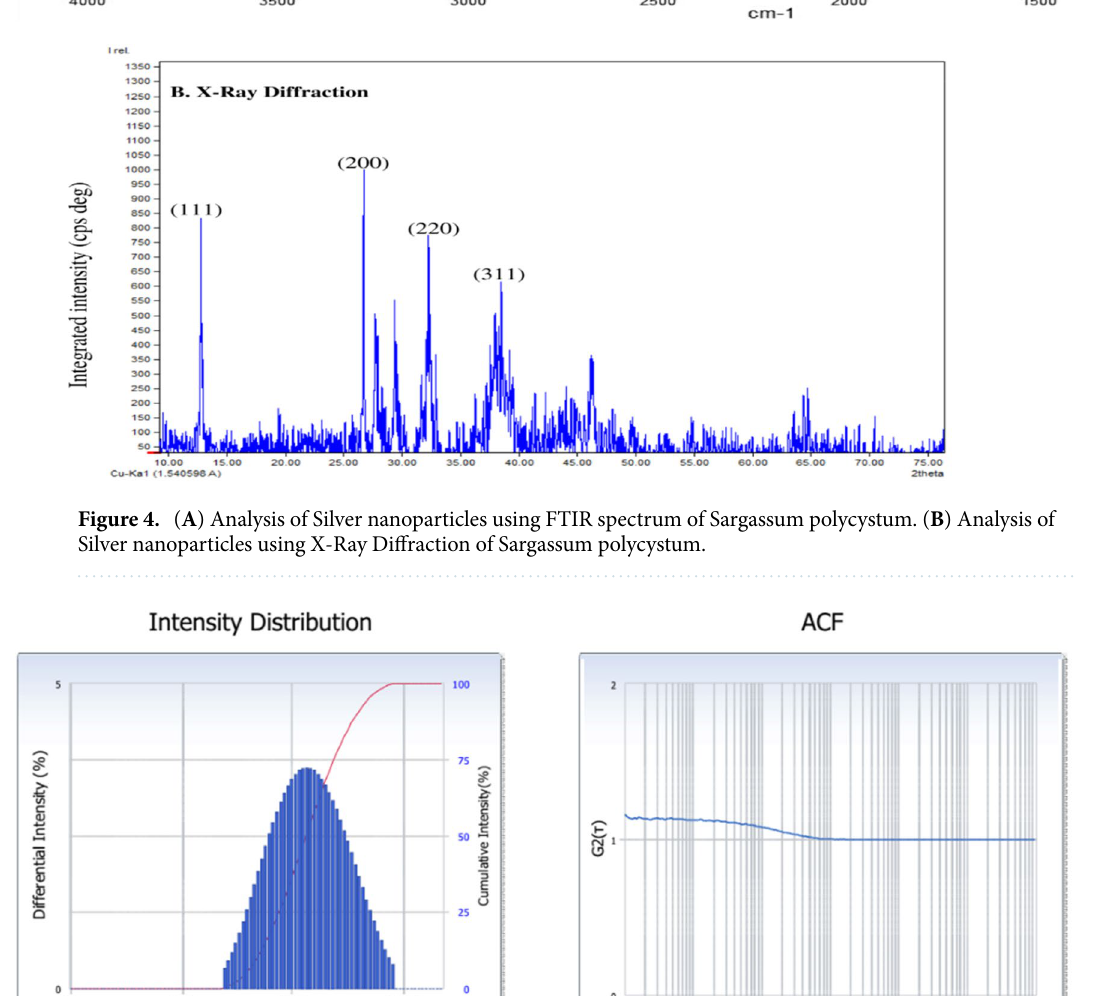
Table 1. Fourier transforms infrared spectroscopy analysis evaluated the functional group of the silver nanoparti- cles. Fourier transforms infrared spectroscopy (FTIR) spectrum was used to evaluate the functional or bio mol- ecules in green synthesis of silver nanoparticles using Sargassum polycystum . The peaks 3888.62 cm −1 indicating the presence of Alcohol (O–H), than 3395.99 (cm −1 ) indicating the presence of Stretching of Amide II (N–NH), followed by 2921.93 (cm −1 ) indicating the Aklanes (–CH2–), 2129.99 (cm −1 ) demonstrating Alkyanes (–C–C)